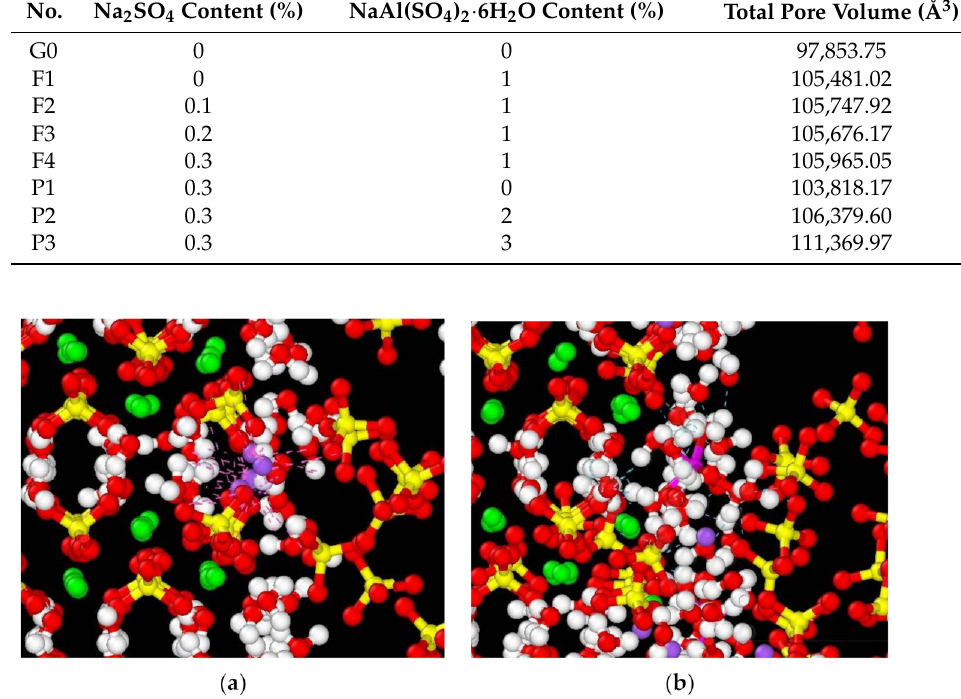
Table 3. Effects of different content Na 2 SO 4 and NaAl(SO 4 ) 2 · 6H 2 O on total internal pore volume.